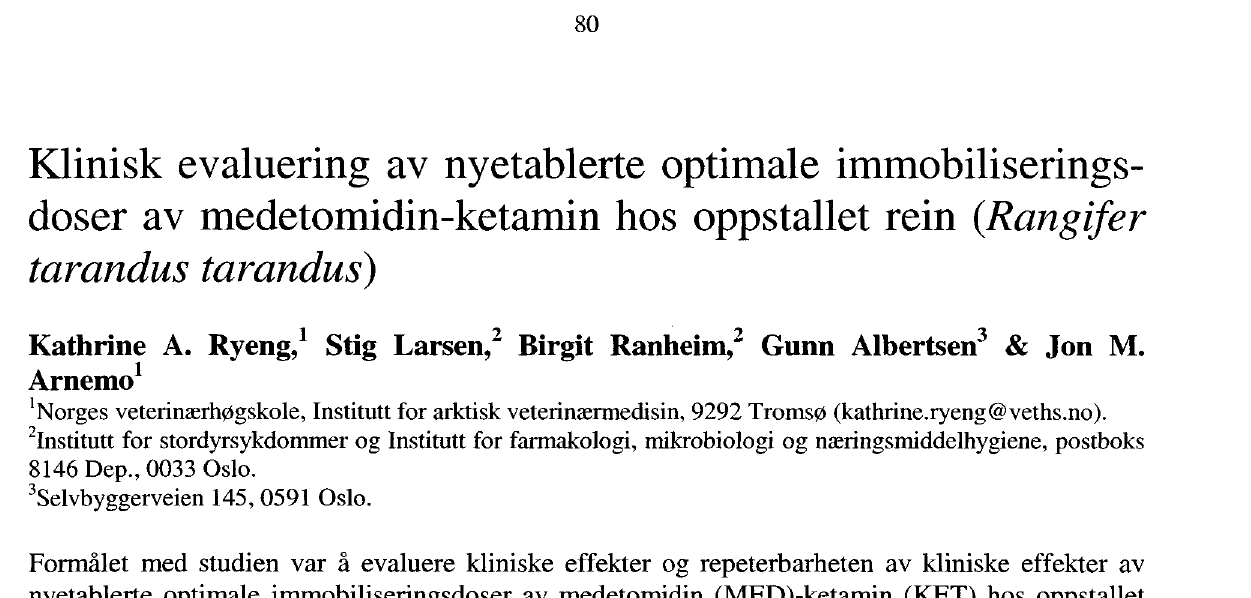
Formålet med studien var å evaluere kliniske effekter og repeterbarheten av kliniske effekter av nyetablerte optimale immobiliseringsdoser av medetomidin (MED)-ketamin (KET) hos oppstallet rein {Rangifer tarandus tarandus). Tolv friske 6- til 8-måneder gamle reinkalver ble inkludert in studien. Hver rein ble immobilisert én gang med en initial dose på 0.06 mg MED/kg kroppsvekt og 0.3 mg KET/kg, og to ganger med en nyetablert individuell optimal dose av MED-KET. Oppvåkning ble oppnådd ved å gi atipamezole i doser 5 ganger MED-dosen, 45 minutter etter administrasjon av MED-KET. Registrerte variable var tid til første tegn på sedasjon, tid til reinen løftet hodet opp, og tid til reinen stod. Oksygenmetning av arterielt hemoglobin (Sp0 ), 2 respirasjonsraten (RR), hjertefrekvens (HF), og rektaltemperatur (RT) ble registrert 10, 25 og 40 minutter etter immobilisering. Gjennomsnittlig tid til første tegn på sedasjon og tid til reinen løftet hodet opp var signifikant reduserte når dyrene ble gitt optimale doser, sammenlignet med den initiale dosen. Gjennomsnittlig Sp0 forble > 90% under immobilisering med initialdosen, var 2 signifikant lavere ved de optimale dosene men steg i løpet av immobiliseringsperioden fra 85 til 89%. Ved alle dosene økte RR signifikant gjennom hele registreringsperioden, men RT og HF var ganske konstante og sammenlignbare med tilsvarende verdier målt hos rein om vinteren. Med unntak av tid til reinen stod, var alle tidsvariable, Sp0 , RR, RT, og HF repeterbare. Immobilisering 2 av oppstallet rein med de etablerte optimale doser er klinisk akseptabelt, likevel bør Sp0 overvåkes 2 nøye. De optimale dosene produserte de samme kliniske effekter under repetert immobilisering av samme